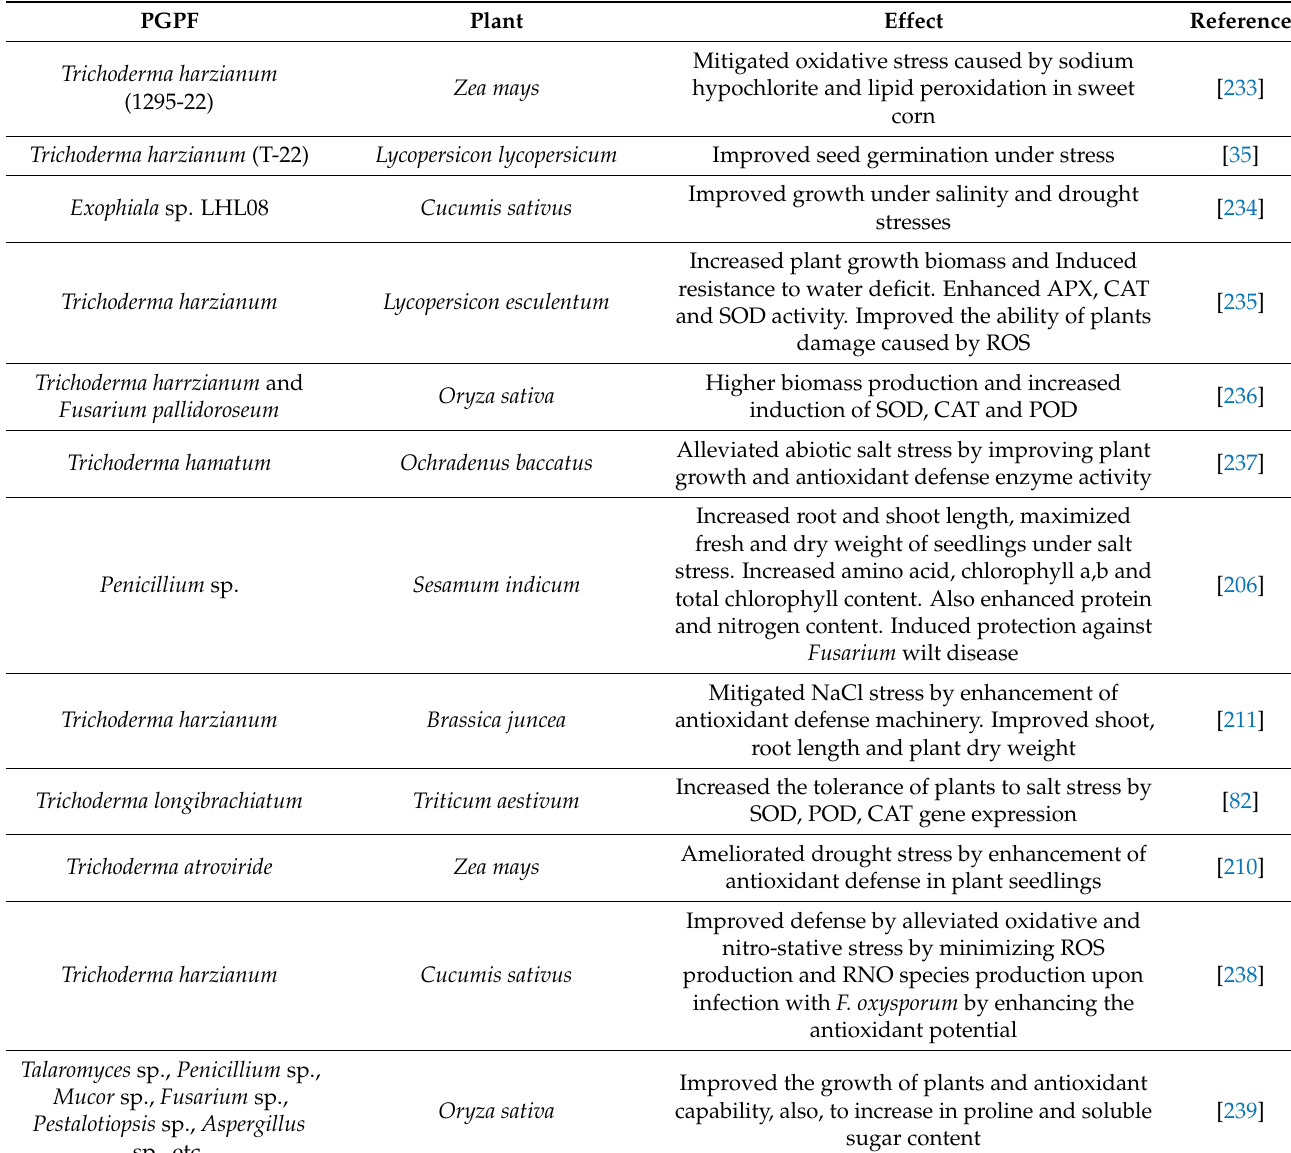
Table 3. Mechanism of abiotic stress tolerance mediated by PGPF in different crop